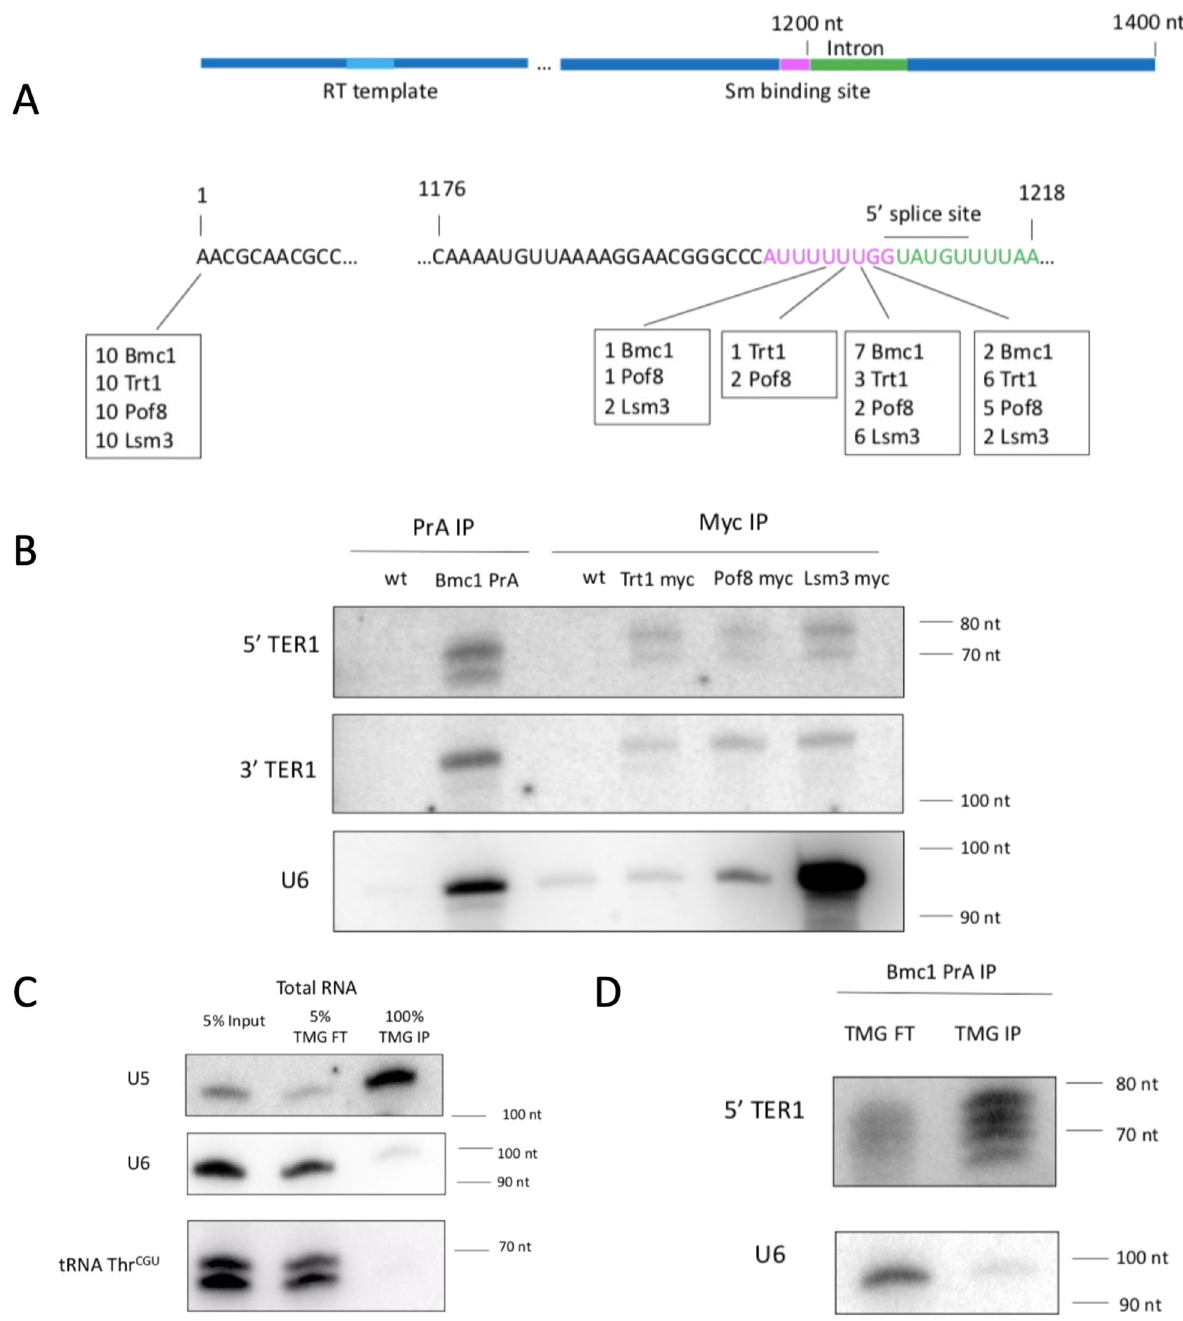
Fig. 2 Bmc1 interacts with the same TER1 species as well-established components of the telomerase holoenzyme. A The 5 ’ and 3 ’ ends of Bmc1-, Trt1-, Pof8-, and Lsm3-associated TER1 were identi fi ed by cRACE. The results of ten independent clones per immunoprecipitation are shown below a schematic of the architecture of TER1. B RNase H northern blots of RNase H-generated 5 ’ and 3 ’ ends of TER1 immunoprecipitated by various telomerase components. The same blot was stripped and reprobed for U6. C , D Northern blot of α -TMG fl ow through (FT) and immunoprecipitated (IP) transcripts from total RNA ( C ) and Bmc1-associated RNA ( D ). Source data are provided as a Source Data fi